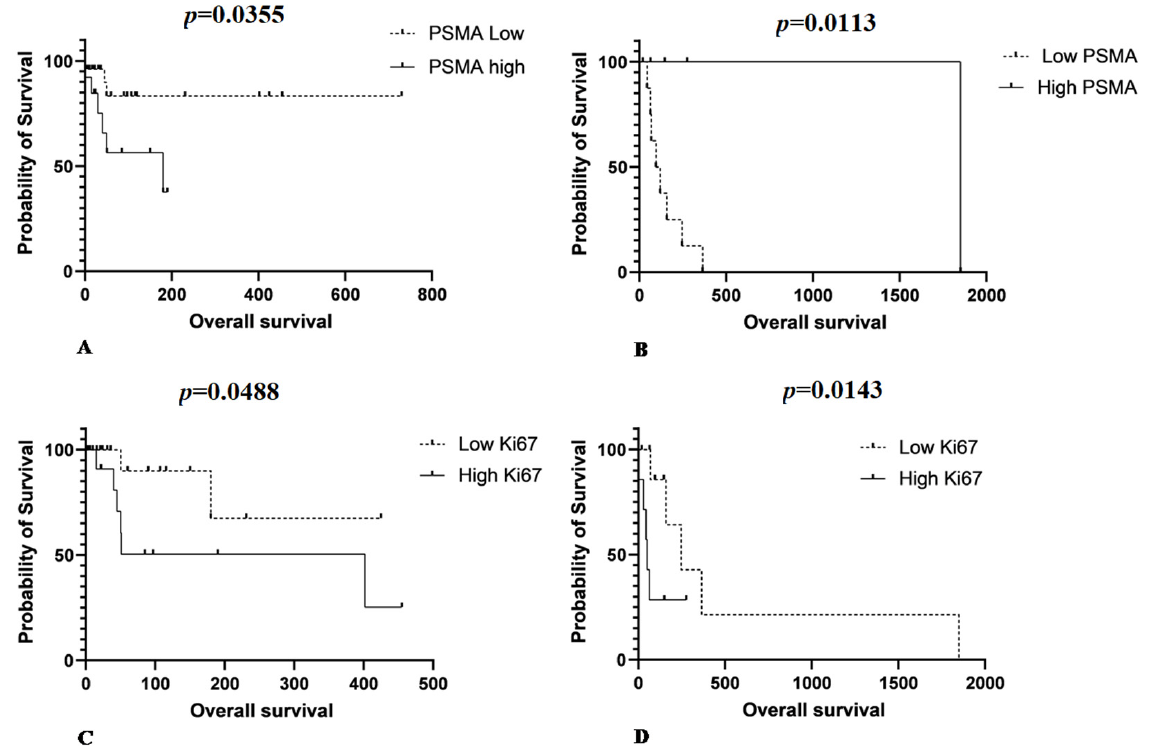
Figure 5. ( A ) Patients that underwent surgery as single therapy show low PSMA protein expression associated with increased survive time ( p = 0.0355). ( B ) Patients treated with surgery associated with chemotherapy show the opposite relationship between PSMA and overall survival. Patients with low PSMA protein expression experience a shorter survival time ( p = 0.0113). ( C ) A longer survival time is observed in patients treated with surgery with a lower Ki67 index ( p = 0.0488) and ( D ) a longer survival time is observed for patients with low Ki67 index in those treated with chemotherapy ( p = 0.0143).